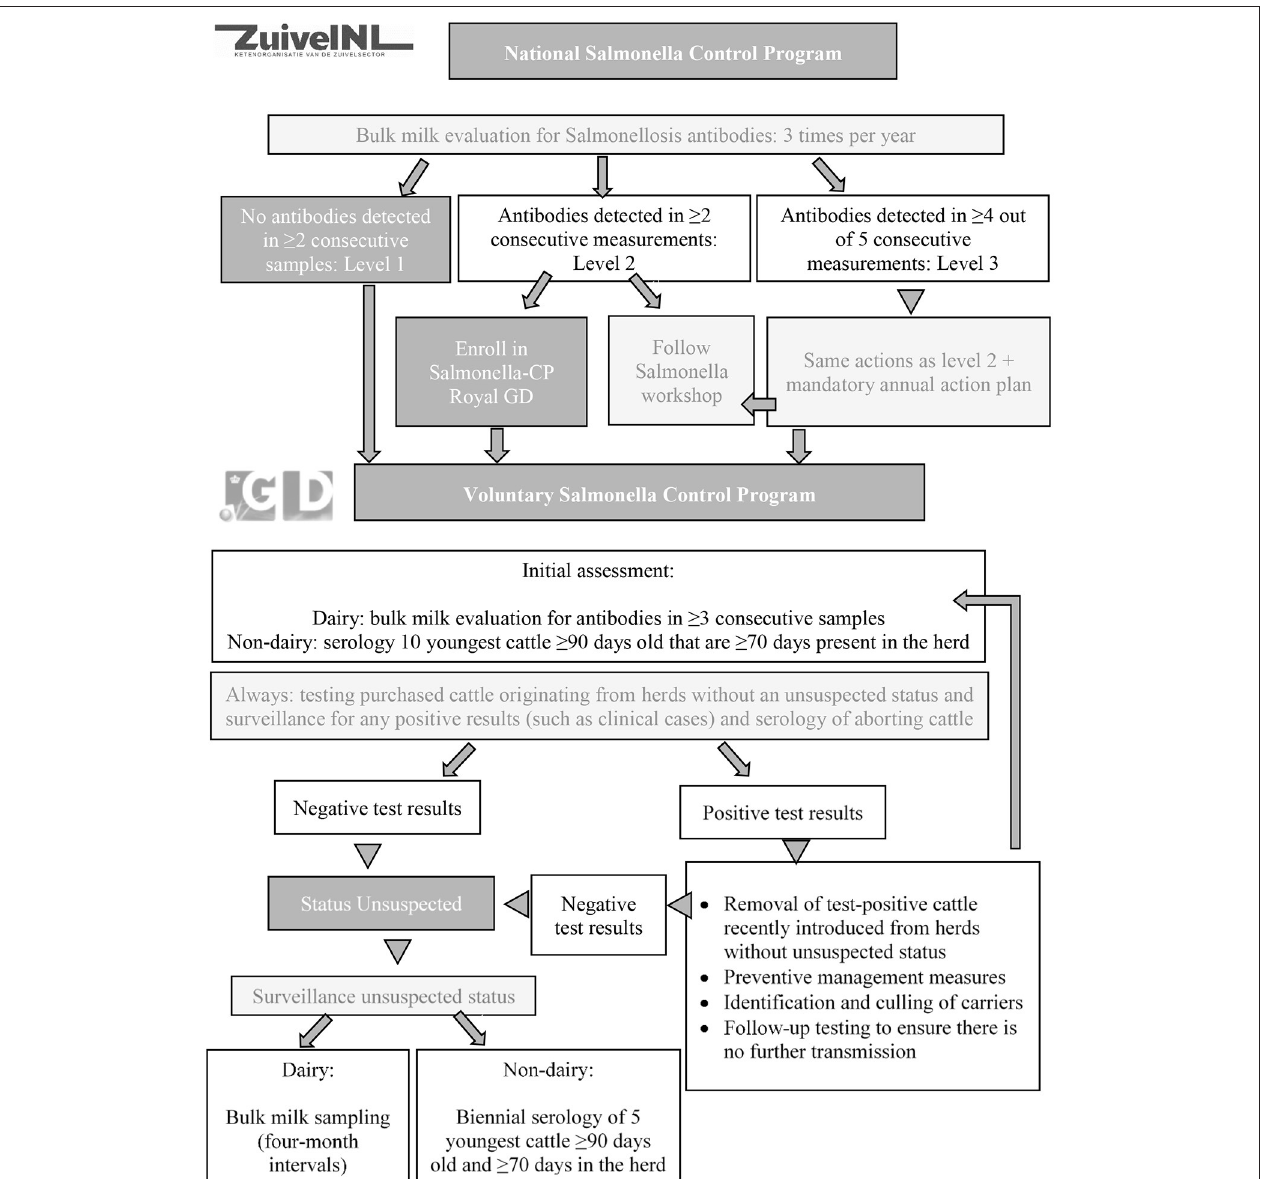
FIGURE 4 | Graphical overview of the national Salmonella spp. control program (ZuivelNL, the Hague, the Netherlands) and the voluntary Salmonella spp. unsuspected control program (Royal GD, Deventer, the Netherlands) in the Netherlands that was implemented in 2009.